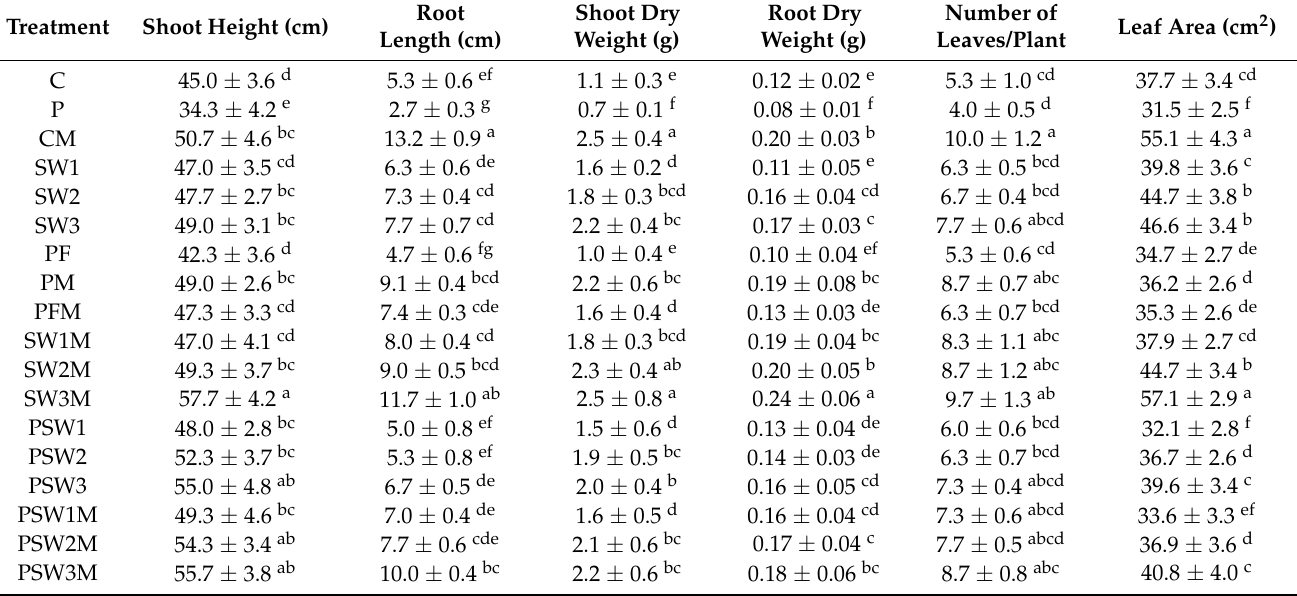
Table 3. Mean growth parameters of pea plants (cv. Master-B) infected with Rhizoctonia root rot in response to treatment with the seaweed extract and/or colonization with arbuscular mycorrhizal fungi at 20 days post-inoculation